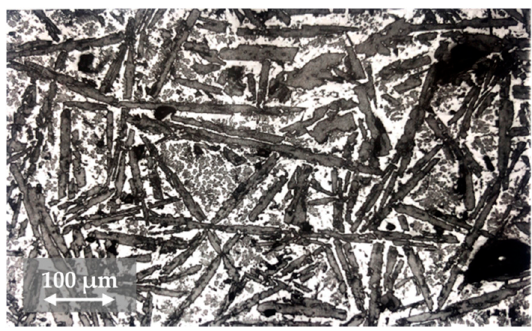
Figure 5. Needles of tricalcium silicate and globular particles of dicalcium silicate in the slag after minute 11 of oxygen blowing, in the melting process B, sample B11.